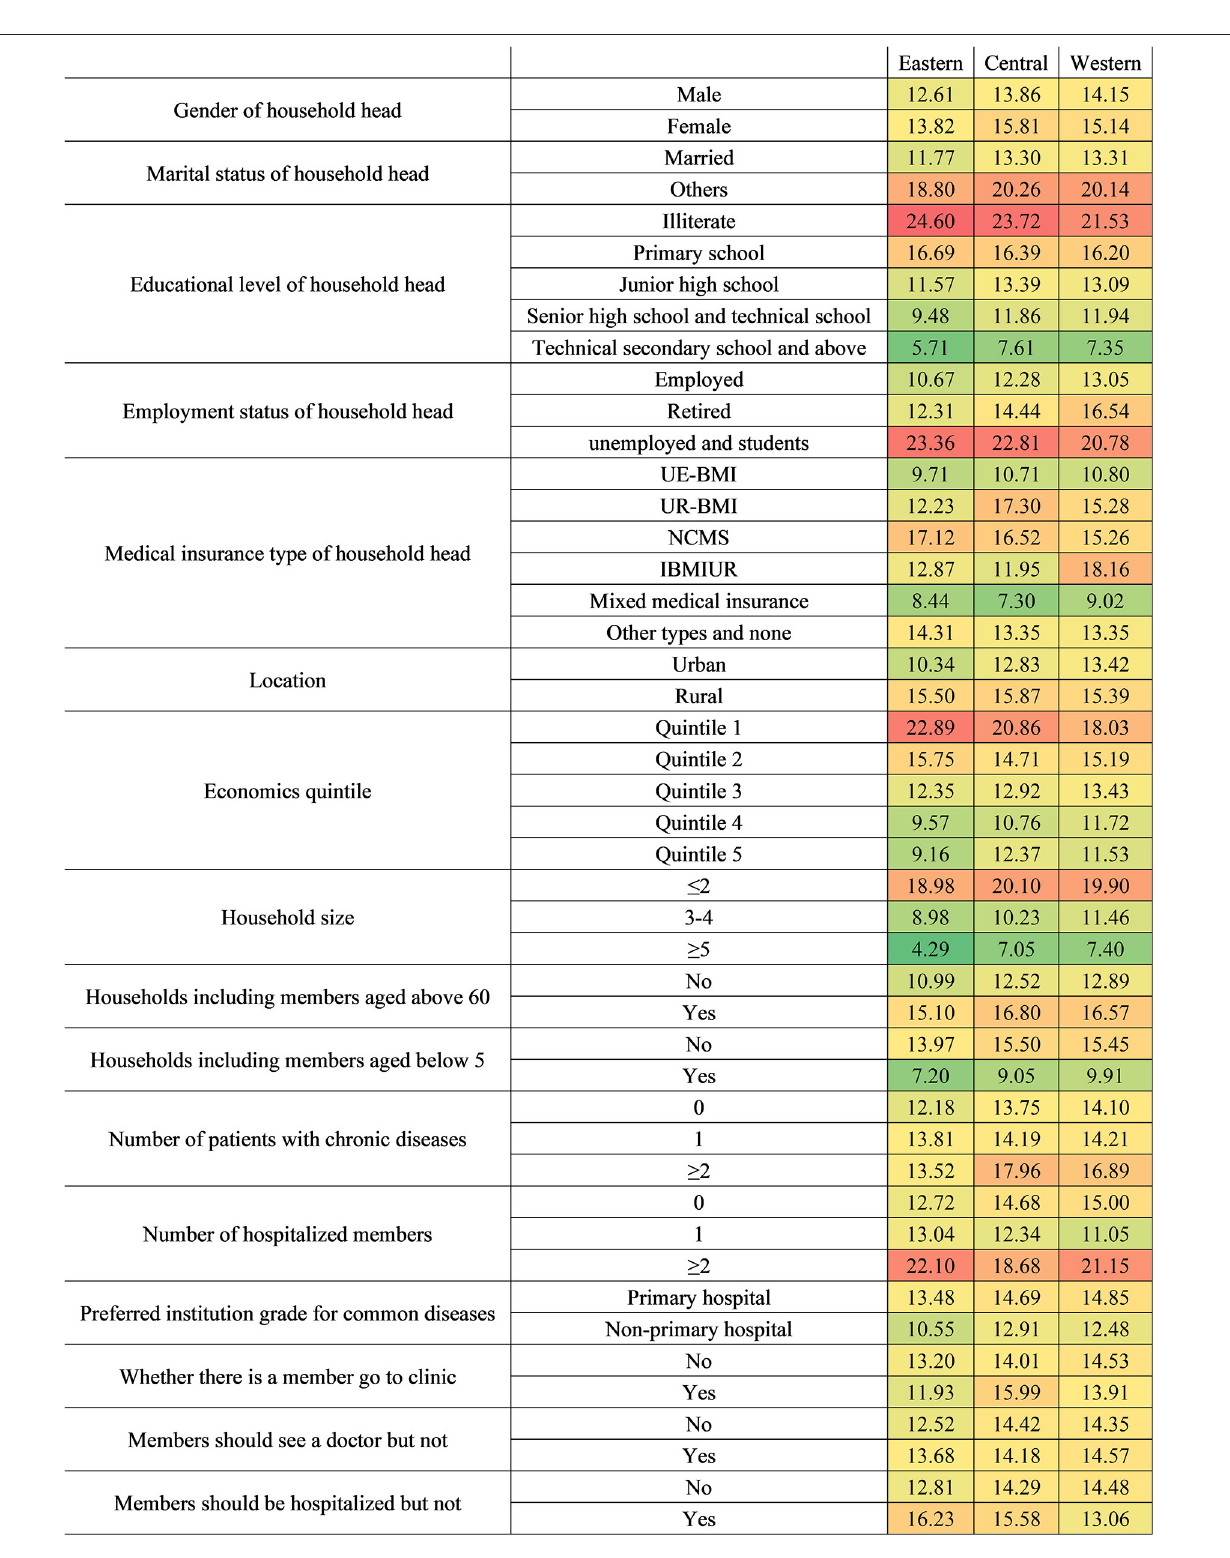
Frontiers in Public Health |